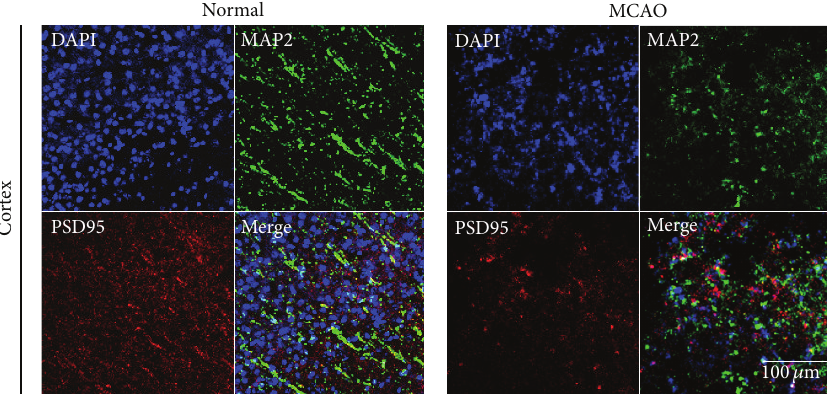
Figure 2: Immunochemical image for confirmation reduced PSD-95 expression in MCAO mouse brain. Immunochemical images showed that PSD-95- (as the post synaptic density protein) positive cells (red) were decreased as expressed in MCAO mouse cortex. Postsynaptic proteinswerehardlyobservedinMCAOmousebraincortex,whereasthenormalcortexwasobservedevidently.Weused5ratsineachgroups for study. Each measurement included 3 repeats per animal. Scale bar = 100 𝜇 m, PSD-95: red, MAP2: green, 4 󸀠 ,6-diamidino-2-phenylindole (DAPI): blue, normal: normal control group, and MCAO: reperfusion 24 hr after MCAO